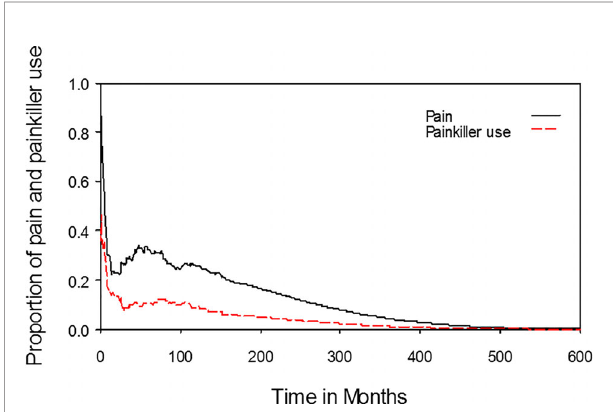
FIGURE 2 | Dynamic change in pain and painkiller use for nasopharyngeal cancer patients.